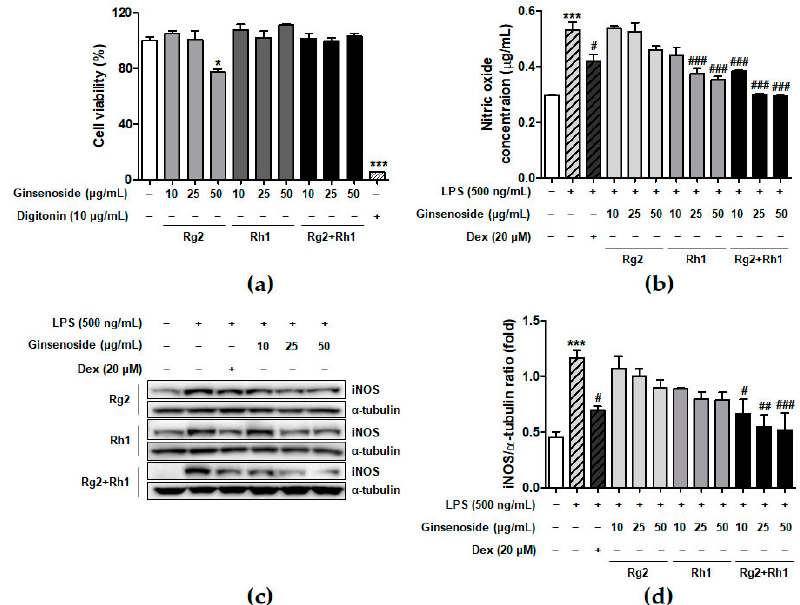
Figure 1. Effect of minor ginsenoside Rg2 and Rh1 on cell viability. ( a ) Cell viability of minor ginsenoside Rg2 and Rh1-treated RAW264.7 cells were measured by 3-(4,5-dimethylthiazol-2-yl)-2,5-diphenyltetrazolium bromide (MTT) assay. The cells were treated with various concentration of Rg2, Rh1, and combination of Rg2 and Rh1 (0 to 50 µ g / mL) for 24 h. In the combination of Rg2 and Rh1, Rg2 and Rh1 were mixed with a ratio of 1:1 (10 µ g / mL of the combination contains 5 µ g / mL Rg2 and 5 µ g / mL Rh1, and so forth). Digitonin was used as negative control. ( b , c ) The production of nitric oxide was examined by Griess assay ( b ), and expressions of iNOS were evaluated by western blot analysis ( c ). ( d ) The ratio of phosphorylated iNOS / α -tubulin expression represents as the mean ± SEM ( n = 3). * p < 0.05, *** p < 0.001 compared with control sample, # p < 0.05 , ## p < 0.01, and ### p < 0.001 compared with lipopolysaccharide (LPS)-treated